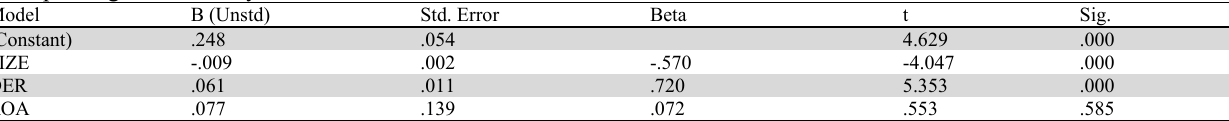
Multiple Regression Analysis